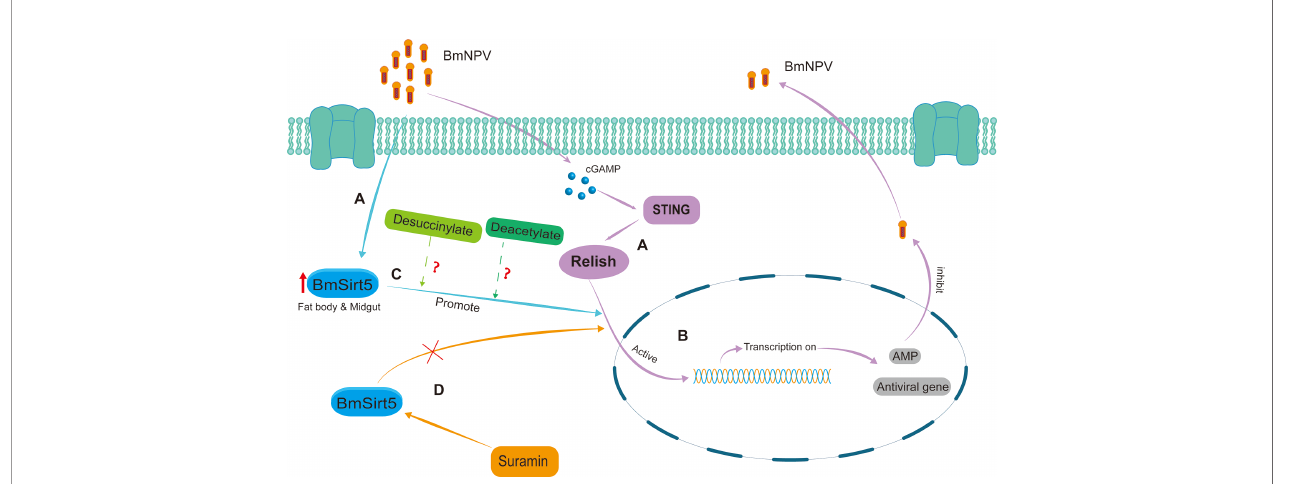
FIGURE 9 | Schematic diagram of the putative antiviral mechanism by which BmSirt5 inhibited BmNPV proliferation in the silkworm. (A) BmSirt5 expression was signi fi cantly induced by BmNPV infection in the fat body or midgut, together with the activation of other host antiviral pathways such as STING. (B) The innate immune pathway mediated by BmRelish can induce the production of downstream antimicrobial peptide (AMP) genes and other antiviral genes to resist BmNPV infection. (C) Nuclear translocation of Relish may be stimulated by de-succinylation or de-acetylation activities of BmSirt5. (D) Inhibition of the NAD + -dependent de- acetylase activity of BmSirt5 by Suramin could interfere with the activation of BmRelish, for instance by inhibition of its transfer to the